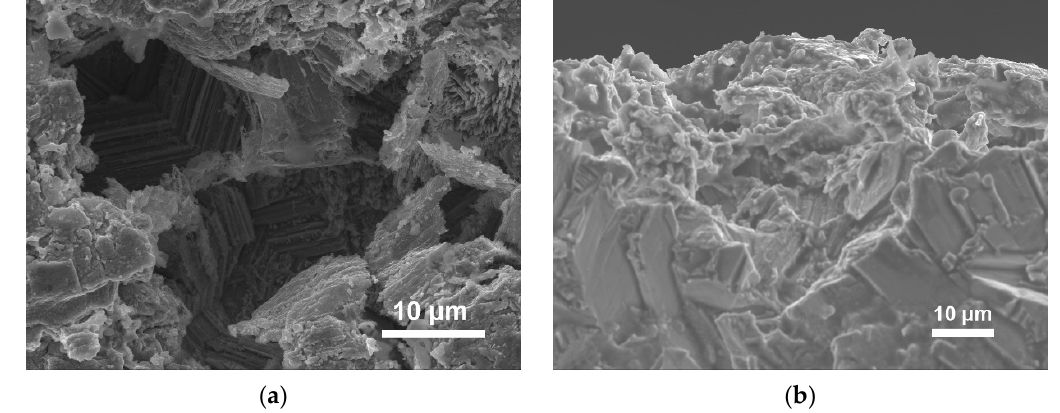
Figure 5. High magnification SEM Images. ( a ) SEM images of the surface morphology of the zinc anode in the battery stored for 20 days (top view). ( b ) SEM images of the surface morphology of the same zinc anode (sectional view).